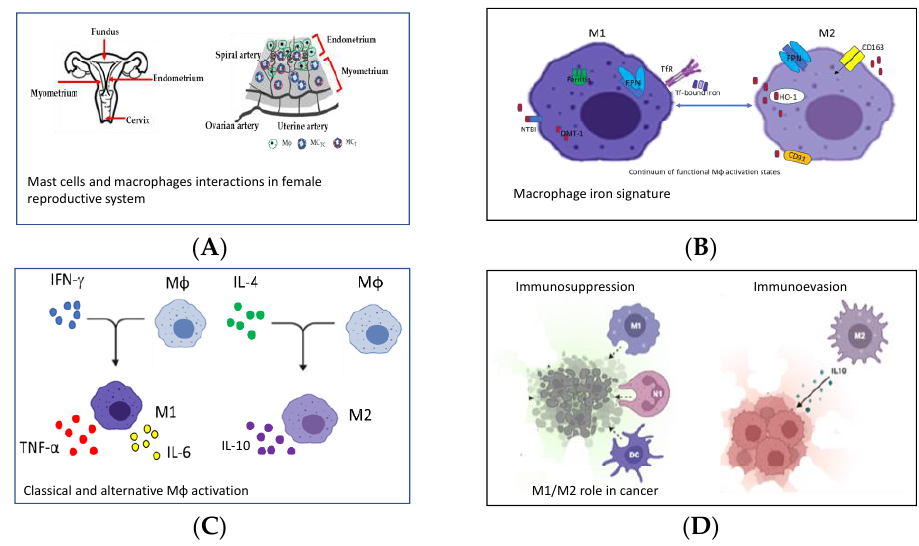
Figure 1. Representative pictures of the four reviews published in the Special Issue. This figure was generated with BioRender and PowerPoint. ( A ) Mast cells and macrophages interactions in emale Reproductive System [1]. ( B ) Macrophage iron signature [2]. ( C ) Classical and alternative M ϕ activation [3]. ( D ) M1/M2 role in cancer [4].